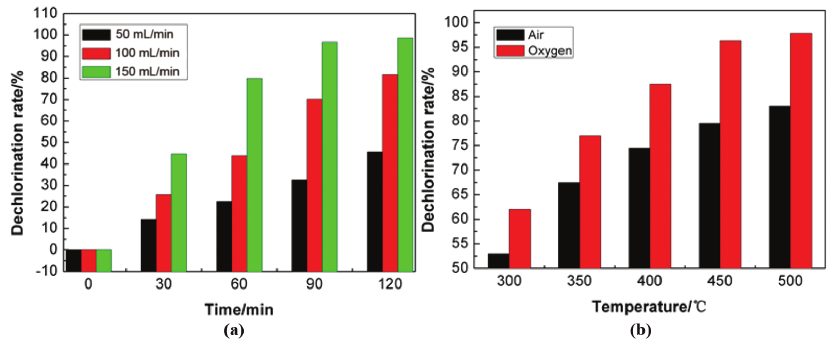
Figure 5: The dechlorination rate of CuCl residue at different temperature, time and oxygen flow rate: (a) the effect of roasting time and oxygen flow rate at 450°C and (b) the effect of